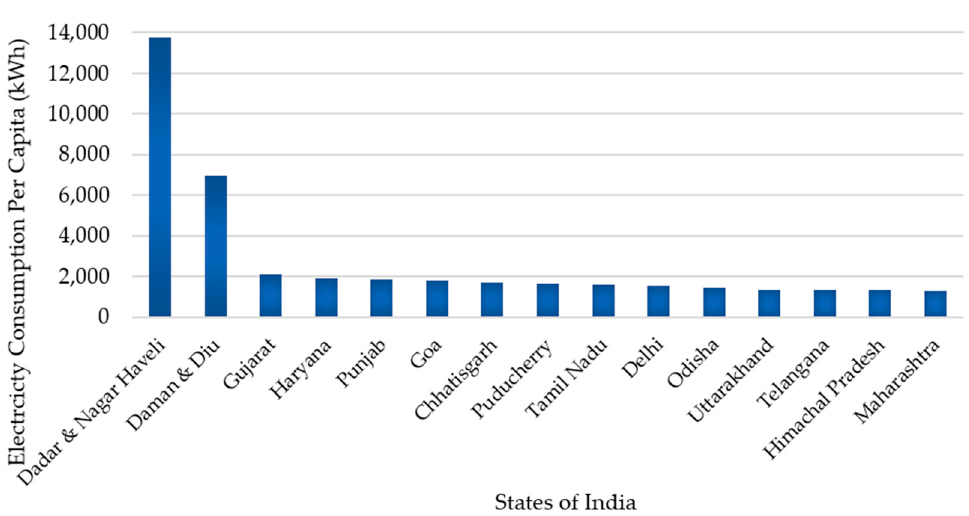
Figure 6. Electricity Consumption Per Capita of India state-wise [28].